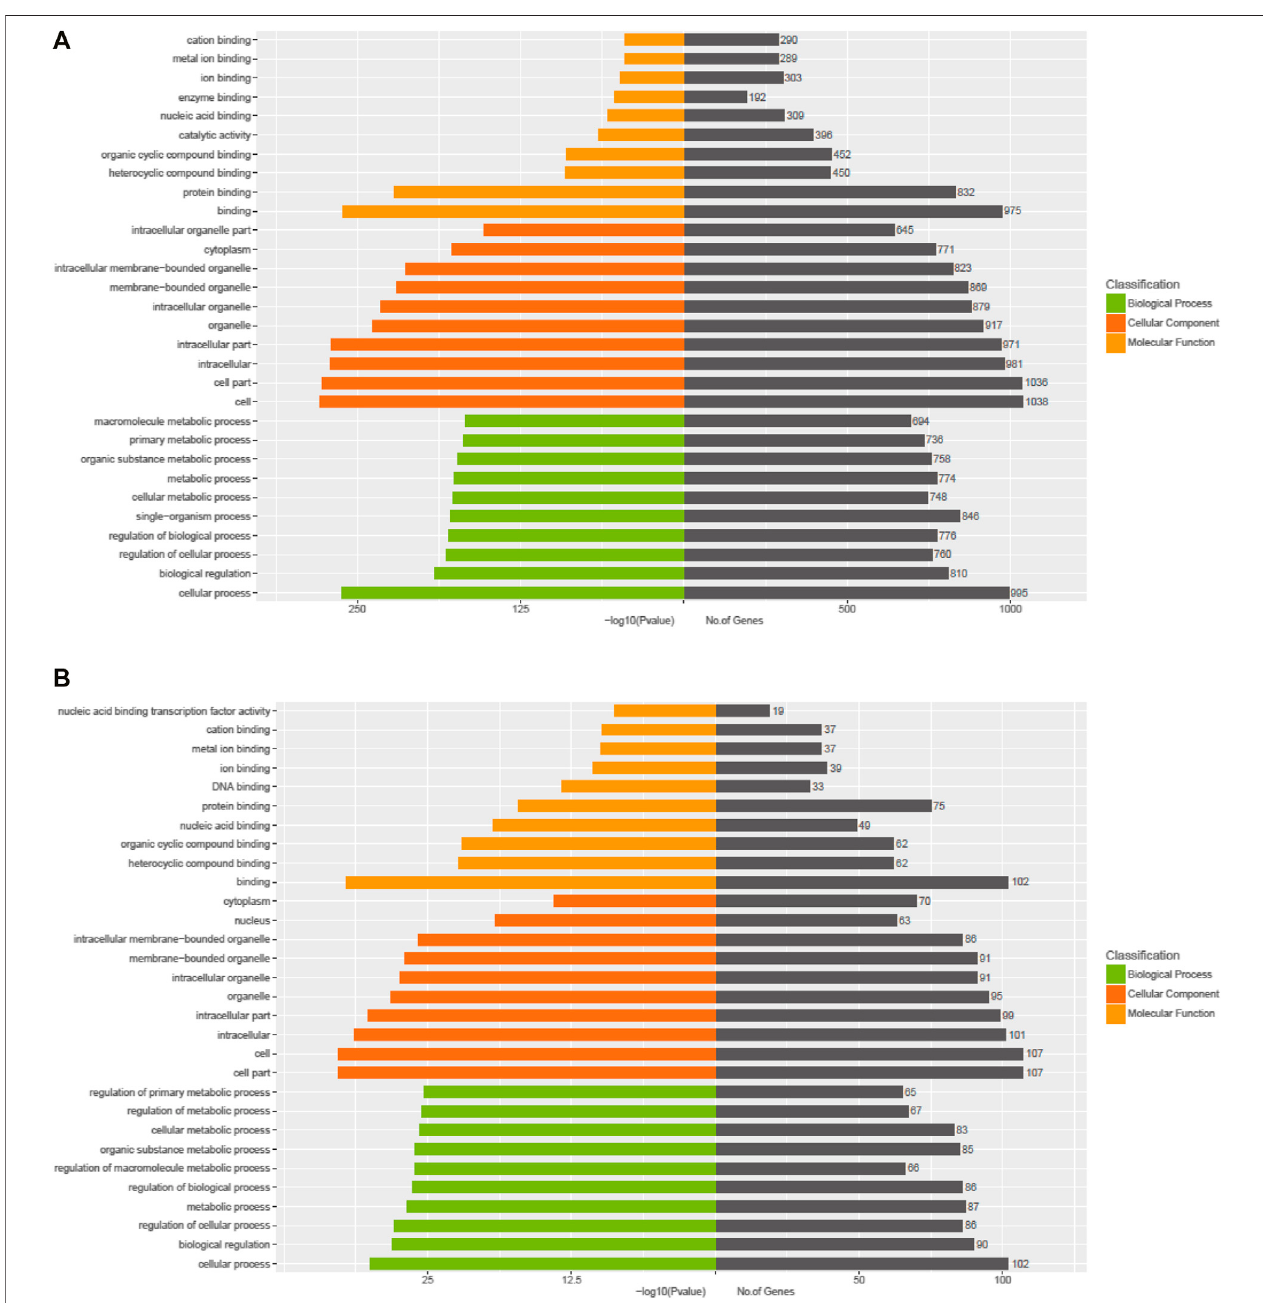
FIGURE 4 | GO enrichment analyses of the exosomal miRNAs dysregulated in UC patients compared to the control subjects. (A) Upregulated miRNAs. (B) Downregulated miRNAs.